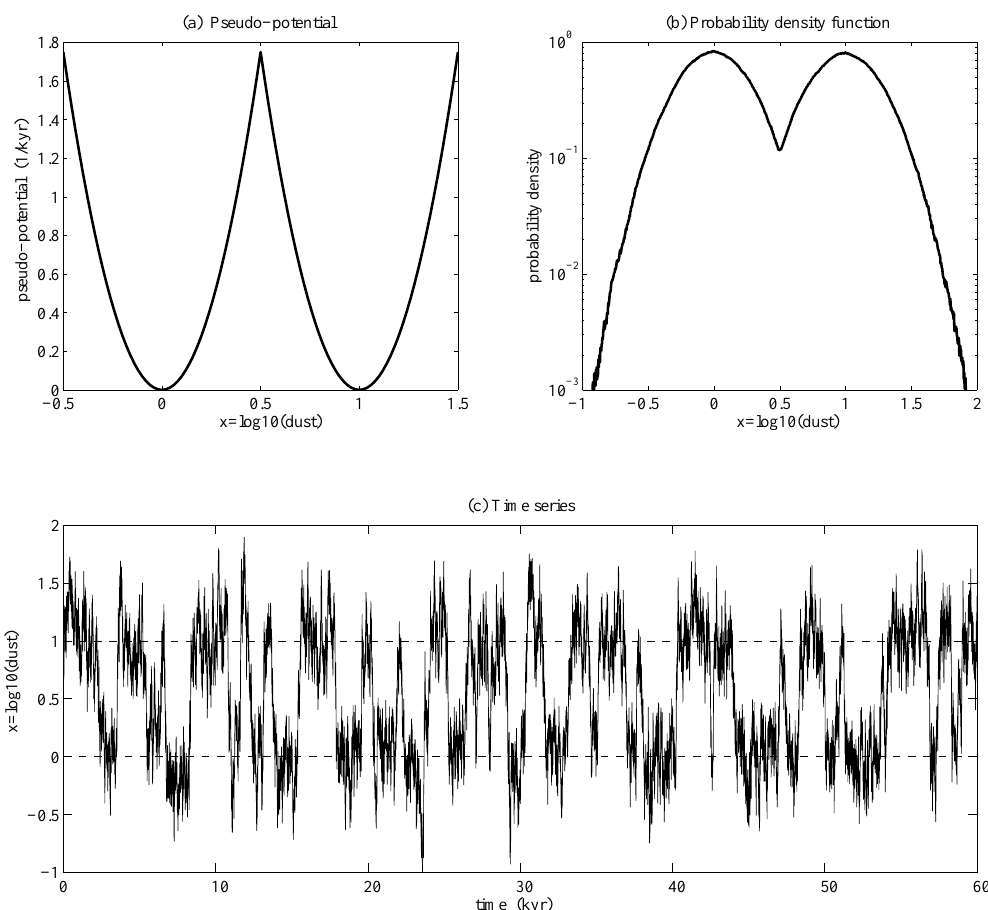
Fig. 2. Langevin Model of Dust Transitions. (a) Pseudo-potential corresponding to the stadial and interstadial equilibria and to the switch between them at x = 0 . 5 , where x = log 10 ( dust ) . (b) Probability of occurrence of states. (c) Time series of transitions between states with waiting time between transitions of 1600 years.